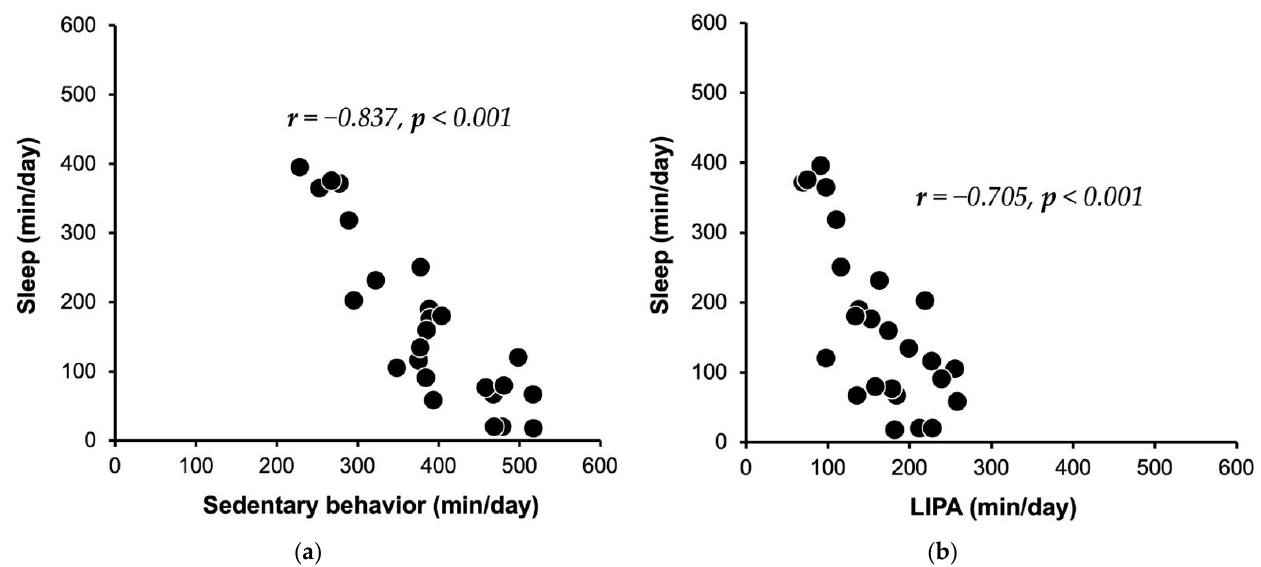
Figure 2. Scatter plots showing the associations for each physical activity intensity, showing data from 25 subjects. Each marker corresponds to an individual subject and is commonly used in plots (a,b). LIPA: low-intensity physical activity. Table 3. Correlation between each physical activity intensity and physical function ( n = 25). Berg Balance Scale Timed up and Go